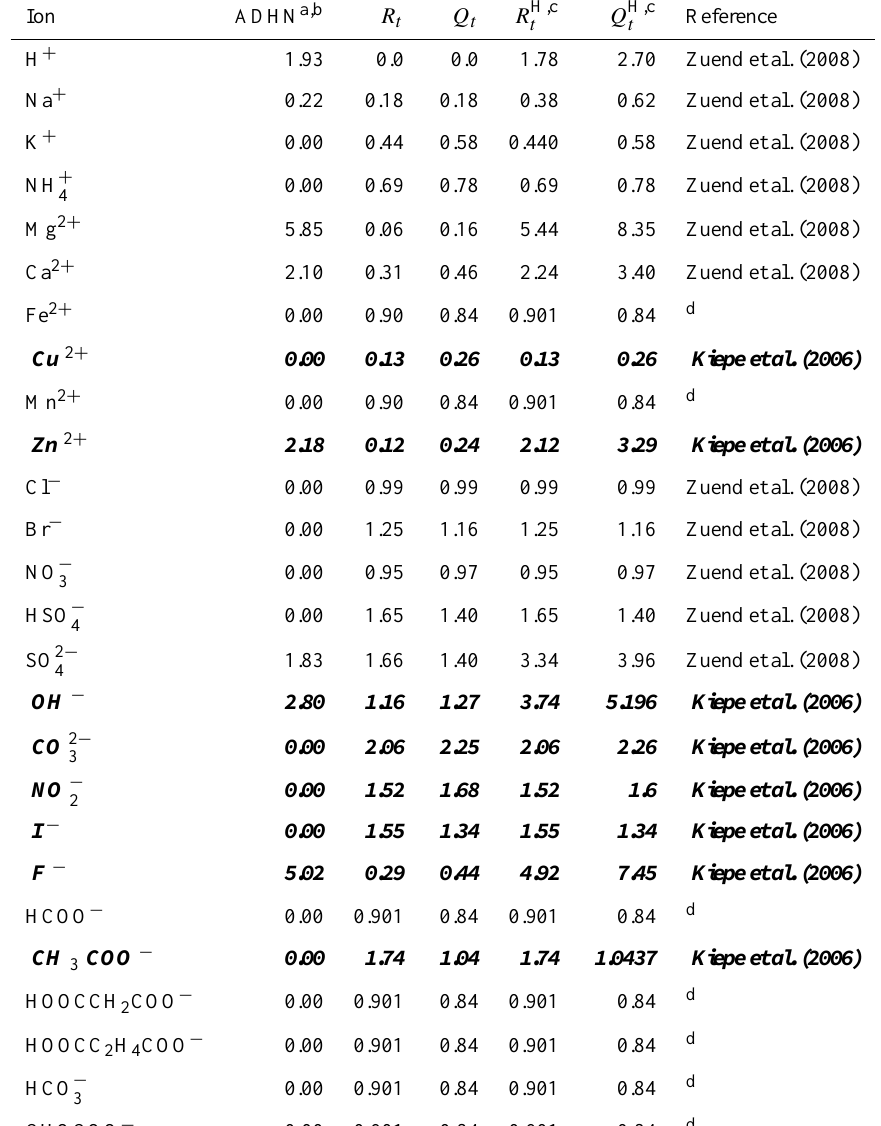
Table A6. Relative van der Waals subgroup volume ( R H t ) and surface area ( Q H t ) parameters for cations and anions considering dynamic hydration. Values from AIOMFAC and mod. LIFAC are presented in regular and bold italic , respectively. Ion ADHN